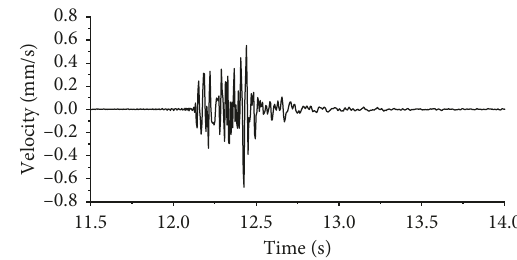
Figure 12: A typical recorded test signal (no. 1).